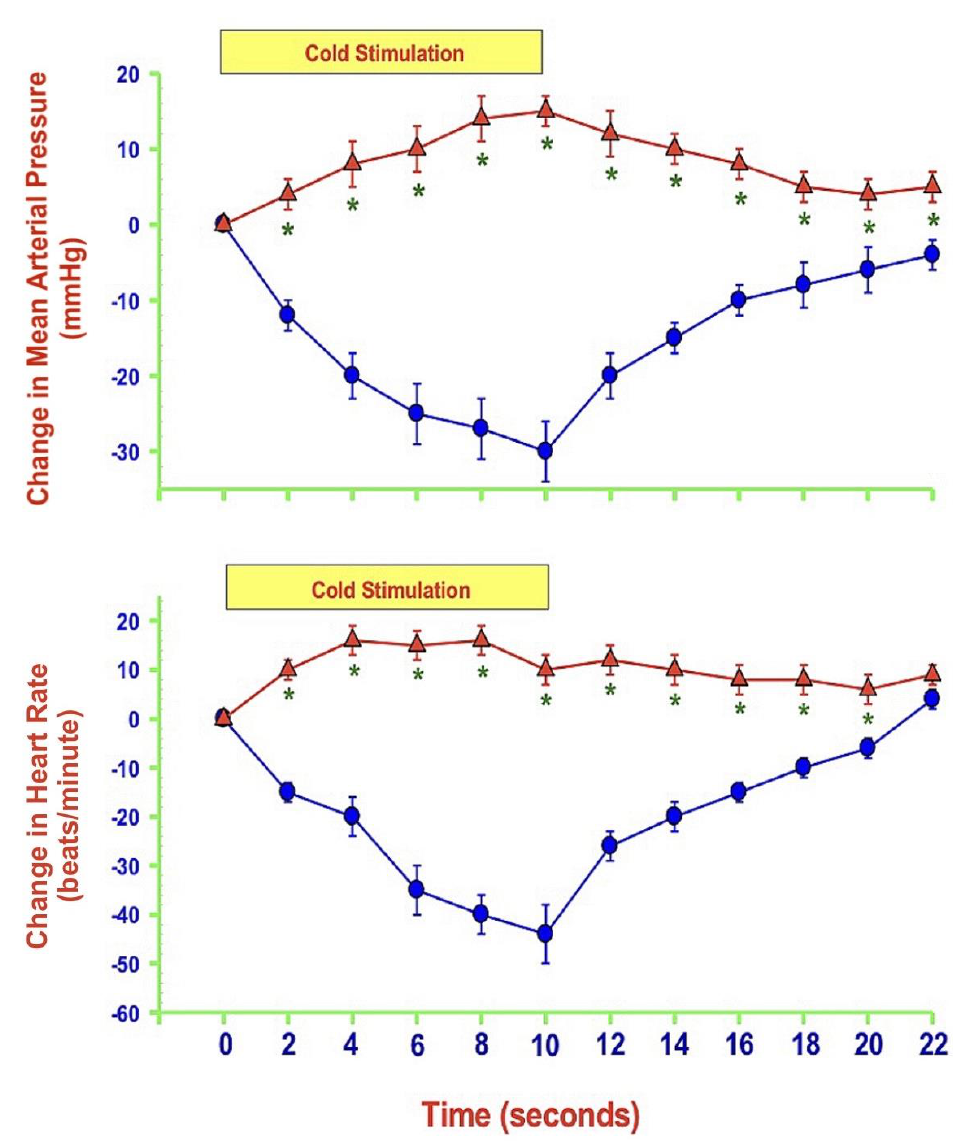
Figure 5. Average time-course changes in mean arterial pressure (MAP: upper panel) and heart rate (HR: lower panel) during 10 s hind paw immersion in a 10 °C cold-water bath 120 min after bilateral insertion of microdialysis probes into the periaqueductal gray matter (control: blue circles) and 30 min after microdialysis of L-N(5)-(1-iminoethyl)ornithine (L-NIO: 10 µM: red triangles; an endothelial nitric oxide synthase antagonist) into the dorsolateral periaqueductal gray matter of anesthetized rats. The Y-axes are changes in MAP or HR, and the yellow boxes represent the 10 s time of stimulation. Values represent means ± SEM ( n = 8) and * p < 0.01 represents values versus control.